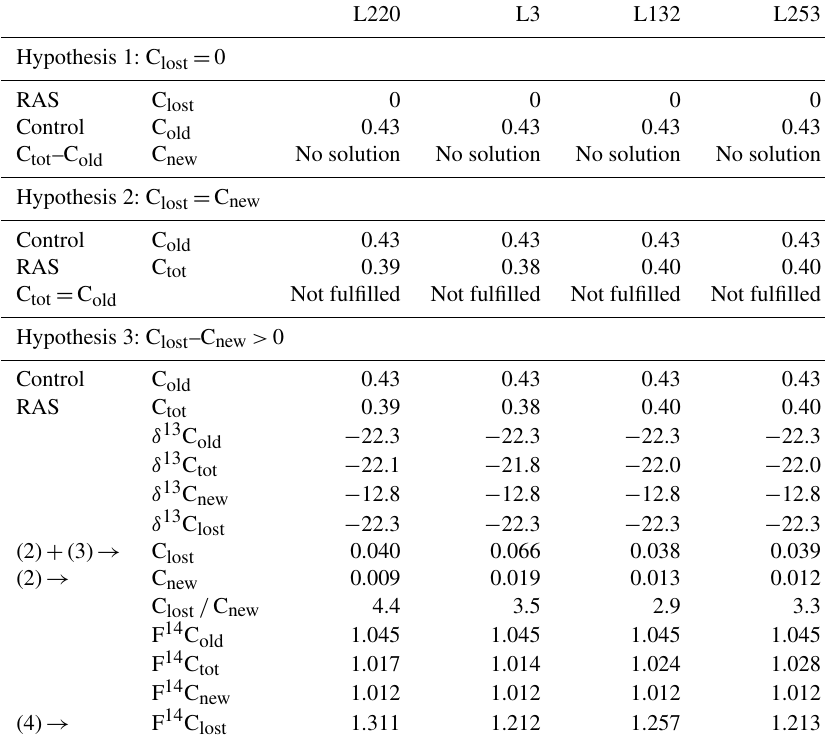
Table 1. Data processing for the root-adhering soil (RAS) of pearl millet lines. Hypotheses 1 and 2 are not solvable with the measured parameters. Hypothesis 3 is the only one that has a solution. The amount of carbon added (C new ), the amount of carbon lost (C lost ) and the radiocarbon fraction of this lost carbon (F 14 C lost ) are then evaluated. Carbon content is expressed in % wt, δ 13 C as ‰, and F 14 C is unitless. The values are given with a digit number in accordance with the number of significant